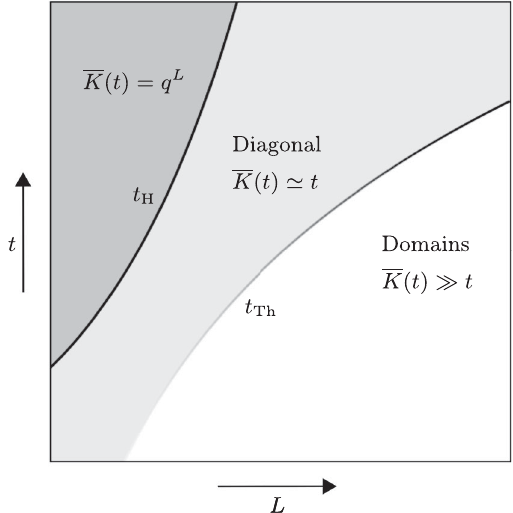
FIG. 4. Different regimes of behavior for the average SFF. See main text for